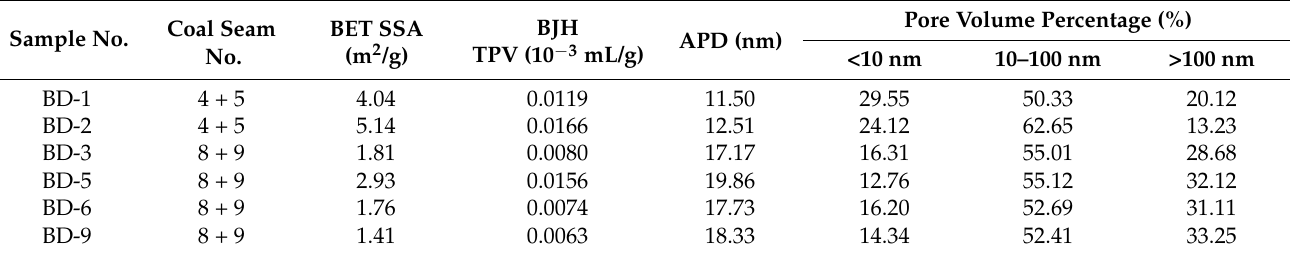
Table 5. Nitrogen adsorption data of typical samples in the study area.